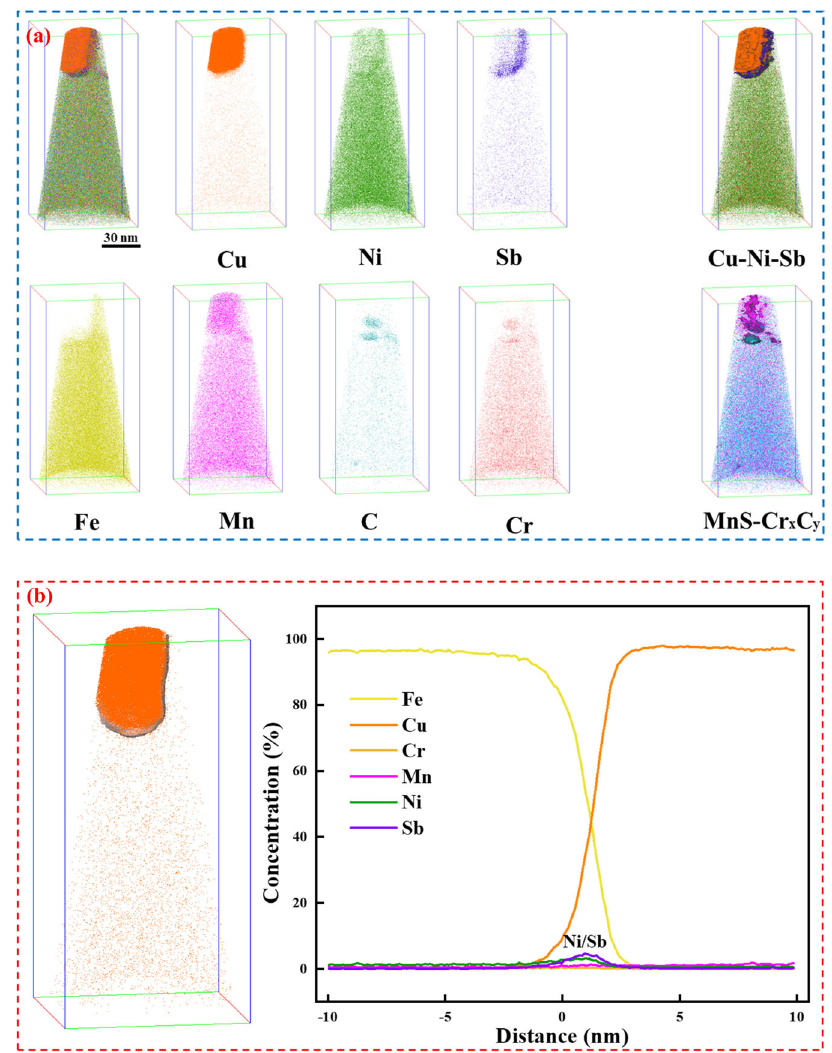
Fig. 7 The element distribution characteristics of Cu-containing inclusion and Cu precipitation interface. a Distribution characteristics of corrosion-resistant elements at the boundary of inclusion and matrix. b Relative content of elements at the interface between the Cu precipitation phase and the